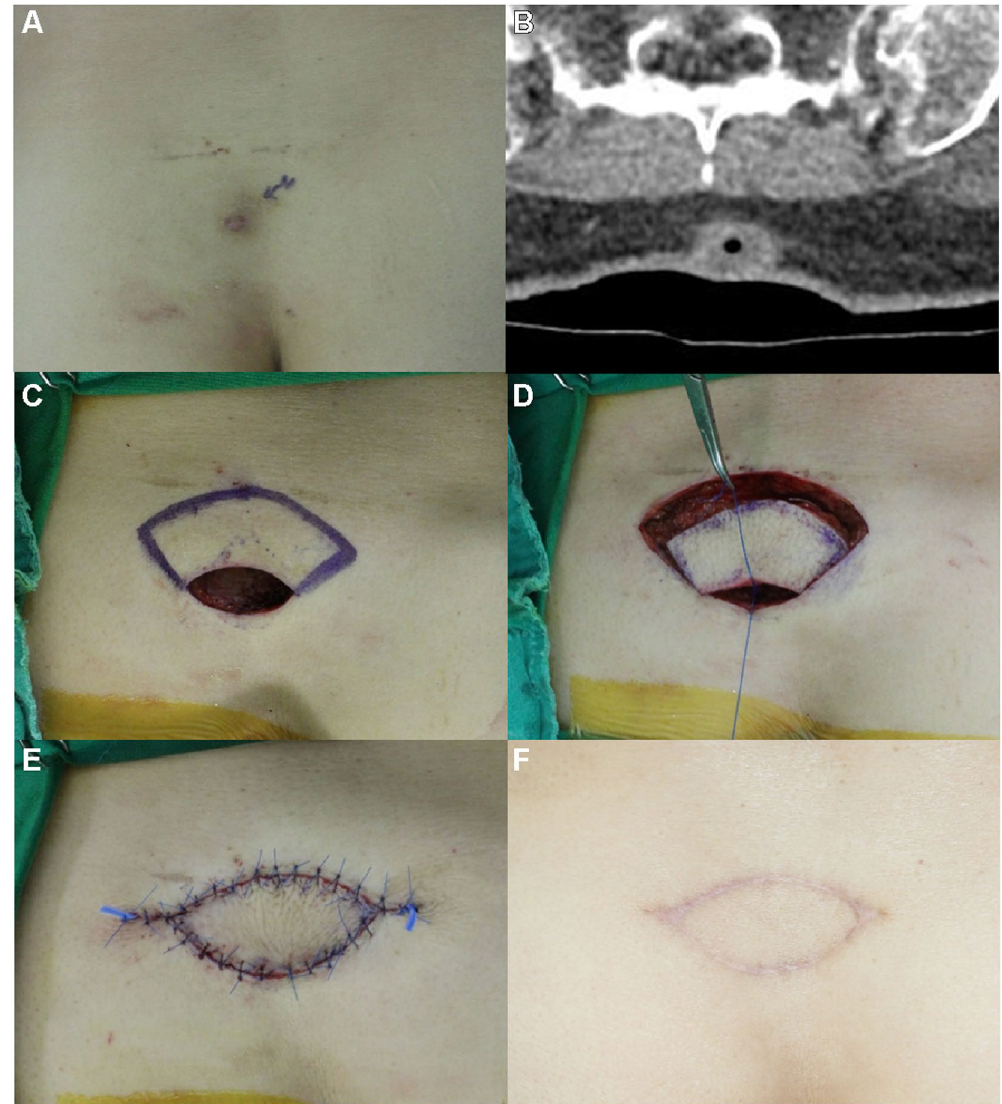
Figure 4. Keystone-design perforator island flap (KDPIF) reconstruction after complete excision of the ruptured epidermoid cyst (EC) with cellulitis in a 59-year-old woman. ( A ) A 3-cm-sized mass-like lesion having unclear border was palpated on her lower left back after administering antibiotic treatment for 1 week. ( B ) Computed tomography scan revealed a 1.5 × 1.8 × 2.5 cm-sized enhancing cystic lesion with inner air from skin to deep fat layer at the level of left upper sacral border. ( C ) The design of the flap. The final defect size was 3 × 3.5 cm, and a 3.7 × 7 cm KDPIF was designed on the upper side of the defect. ( D ) The island-form of the flap was created, and the flap was moved to the defect with minimal tension. ( E ) Postoperative clinical photograph immediately after the flap inset. ( F ) Postoperative clinical photograph of the flap after 11 months of